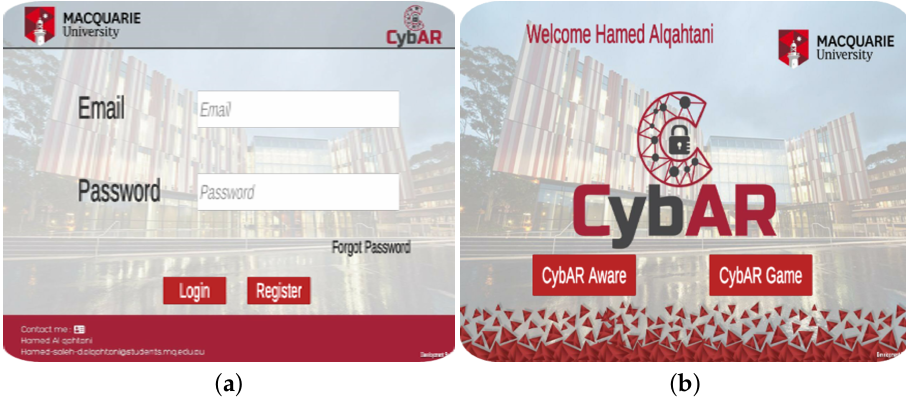
Figure 6. ( a ) CybAR app. ( b ) CybAR login UI.